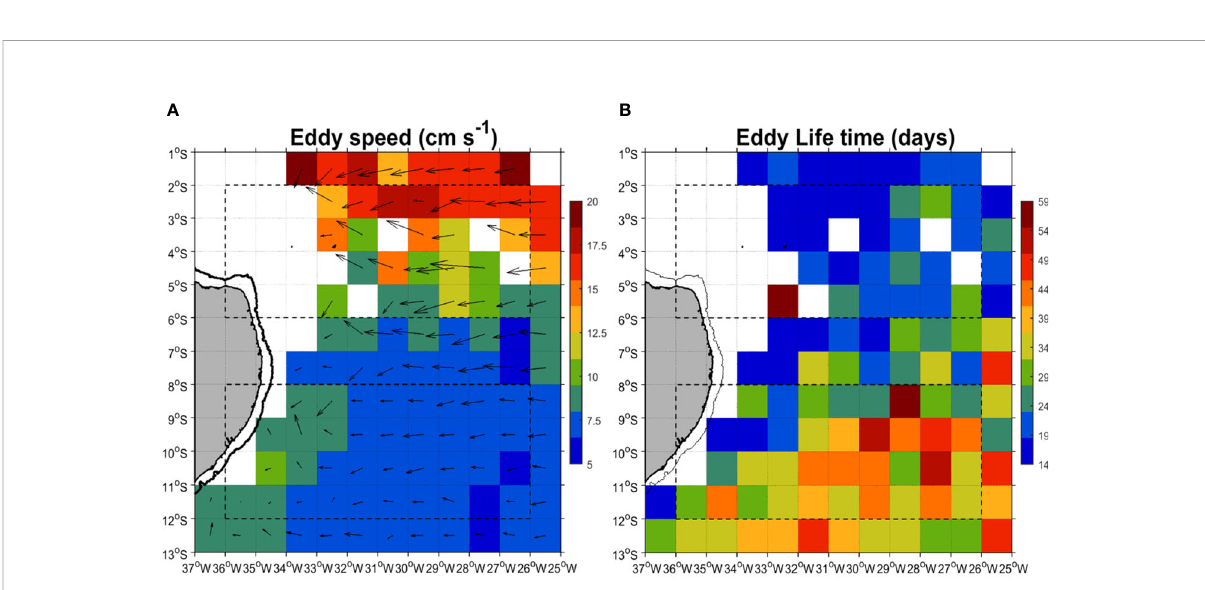
FIGURE 5 Spatial distribution per degree square over 1993-2018 period of (A) mean eddy propagation speed (colors) and direction (arrows) and (B) mean eddy life time off northeast